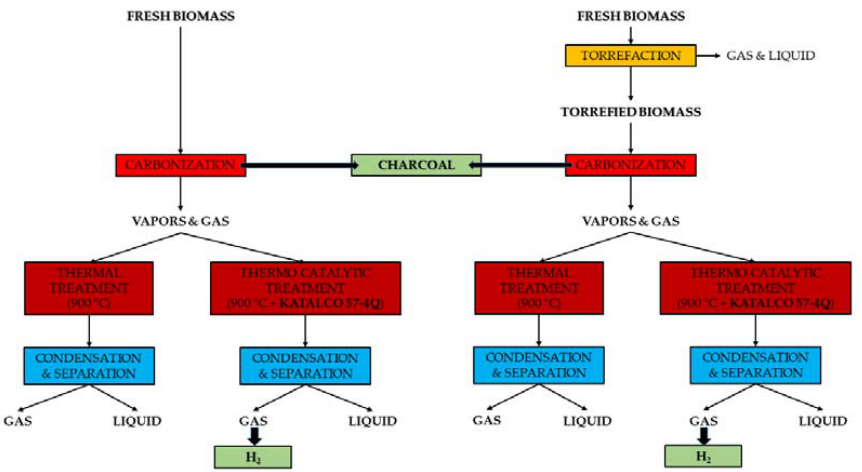
Figure 3. Conceptual scheme of the experiments.